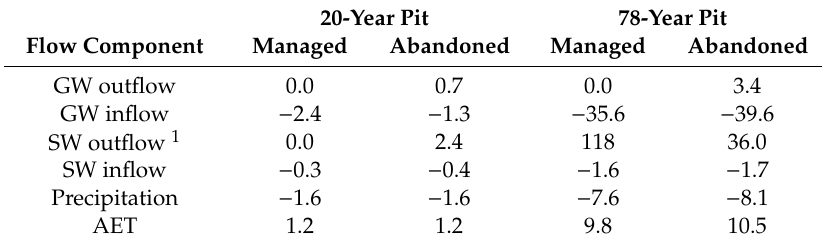
Figure 5. Map showing the location of pit lake overland flow to the South Fork Koktuli watershed headwaters in the 20-year abandoned scenario. An annual average of 3.1 cfs (2.4 cfs in surface water and 0.7 cfs in groundwater) is predicted to flow out of the pit and impact water quality in the South Fork Koktuli River. Table 3. MIKE SHE-simulated average annual pit lake inflows and outflows (cfs) for the 20-year and 78-year managed and abandoned scenarios. Inflows to the pit are negative and outflows are positive in MIKE She